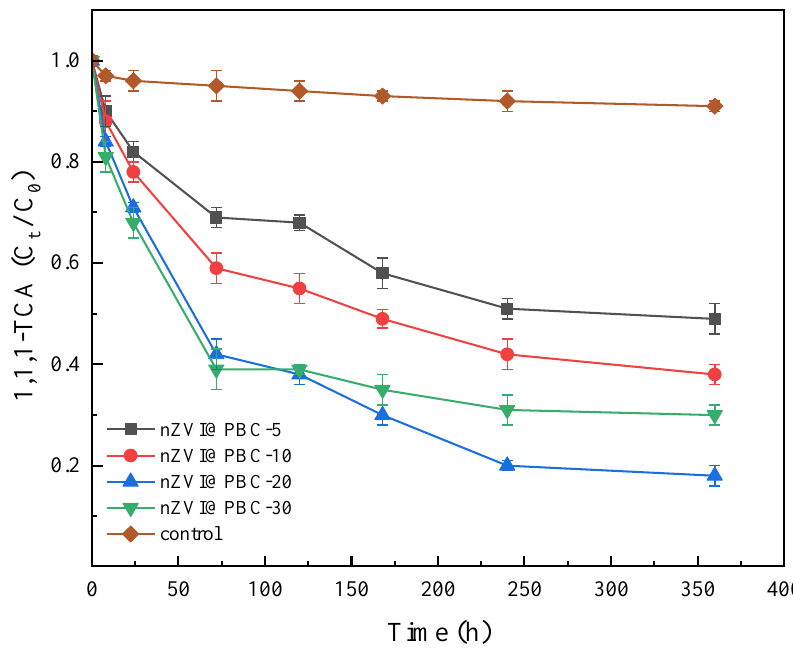
Figure 5. 1,1,1-TCA removal performances of composite materials with different nZVI